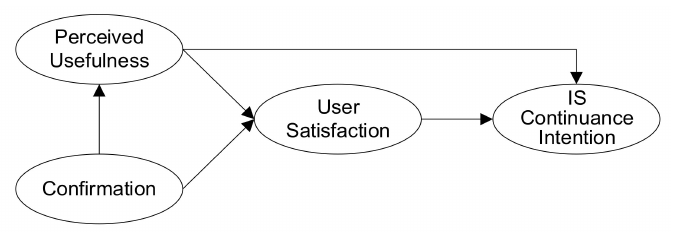
Figure 1. Expectation confirmation theory. Source: [21].